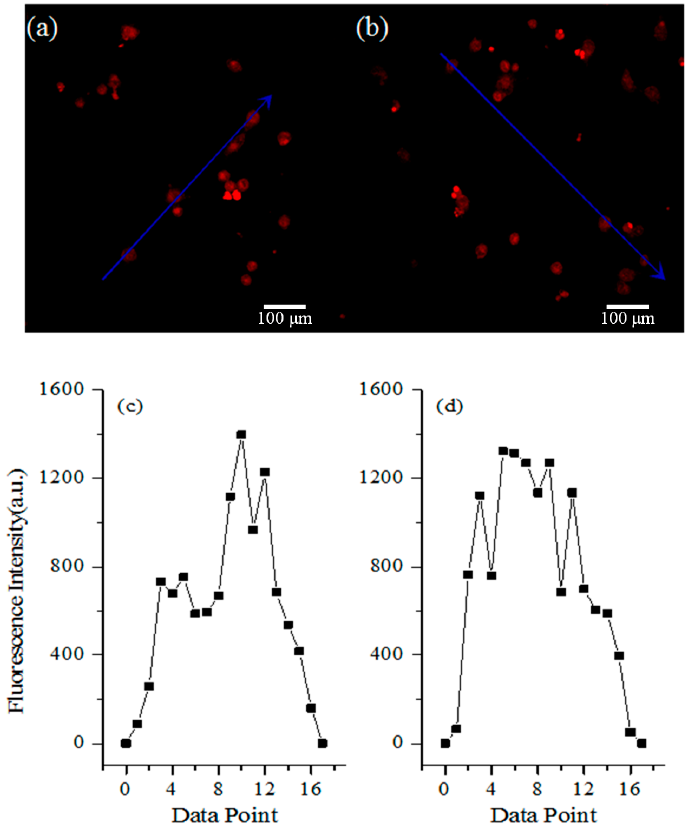
Figure 6. Confocal laser scanning microscope (CLSM) images and fluorescence profiles of UMUC3 cells incubated with: ( a , c ) DOX-loaded PCL1- b -PManEA@ConA micelles (1 mg/mL); and ( b , d ) DOX-loaded PCL1- b -PManEA@ConA micelles (1 mg/mL) + MeMan (20 mM) for 2 h.